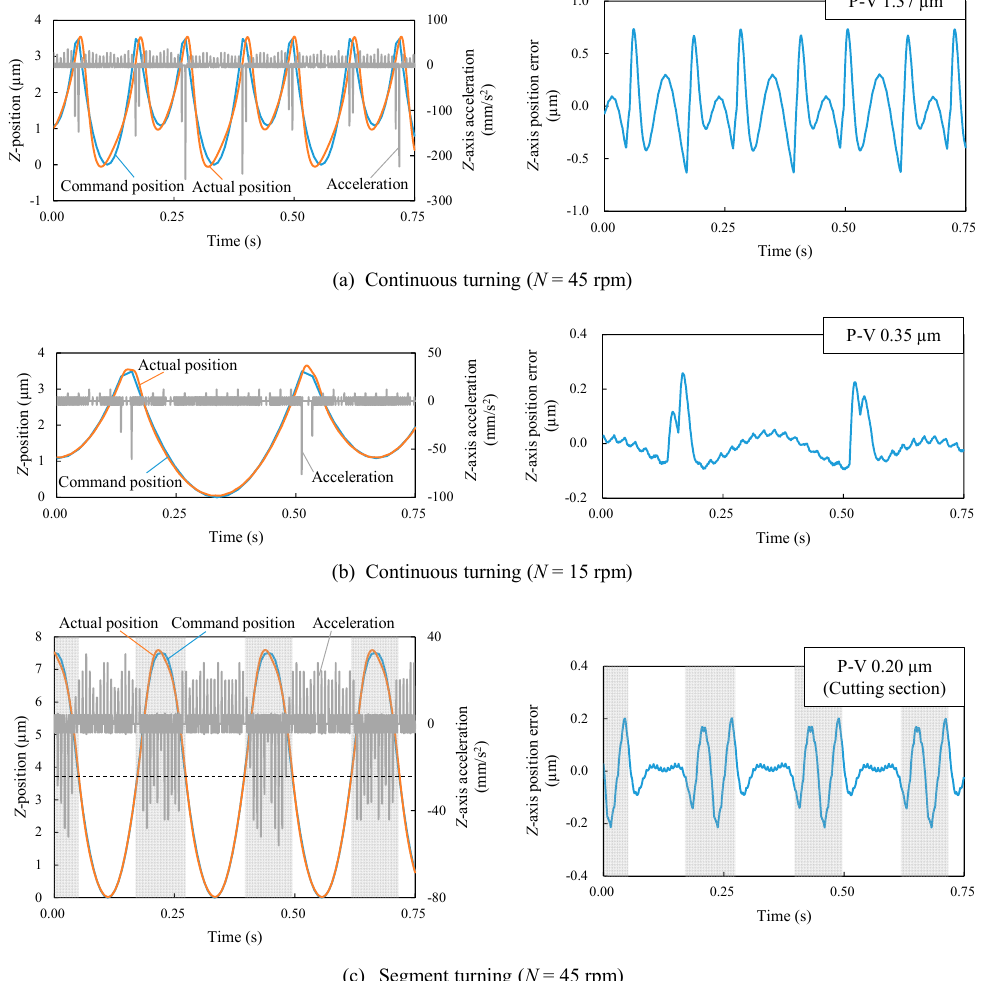
Figure 8. Plots of command positions, actual positions and accelerations (left-side graphs), as well as position errors (right-side graphs) for continuous turning and segment turning. ( a ) Continuous turning ( N = 45 rpm); ( b ) continuous turning ( N = 15 rpm); ( c ) segment turning ( N = 45 rpm).